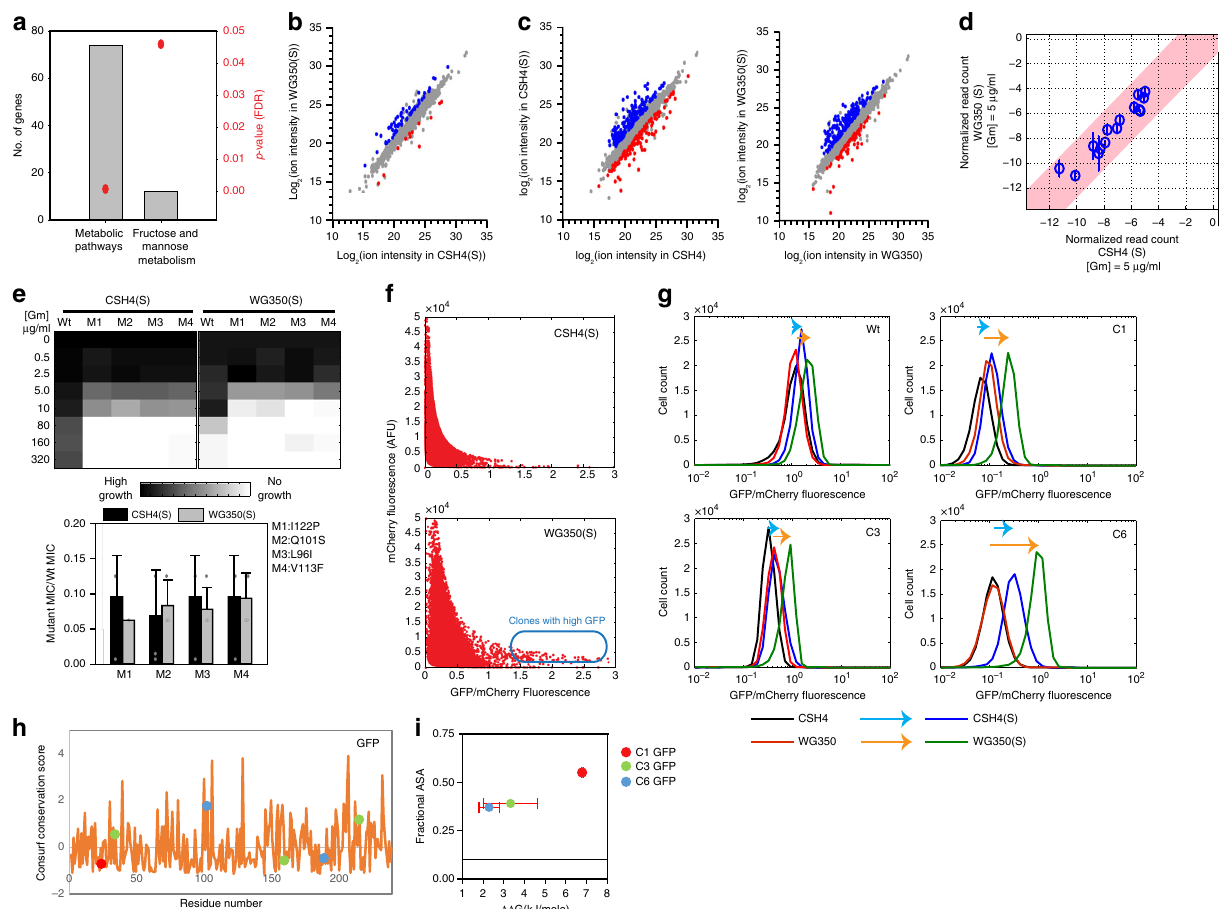
Fig. 3 Osmotic stress-induced changes in metabolism changes the spectrum of mutants buffered. a Gene Ontology (GO) classes upregulated in WG350 (S) transcriptome with respect to CSH4(S) shown as fold enrichment on the left-axis and Benjamini-Hochberg FDR corrected p -values obtained using DAVID on the right axis from two biological replicates. b Comparison of metabolites in WG350 and CSH4 during growth in media containing 350 mM NaCl using untargeted metabolomics. Colored circles represent signi fi cantly different metabolites obtained using paired 2-sided Student ’ s t -test. c Comparison of metabolites within strain in presence and absence of NaCl. Colored circles represent signi fi cantly different metabolites obtained using paired 2-sided Student ’ s t -test. d Mean of normalized read counts of Gm-R GG-mutant library at comparative selection pressure of Gentamicin (Gm) and 350 mM NaCl in growth media from two biological replicates. Pink shaded area marks 99% con fi dence interval. e Heatmap representing activity of small- molecule-dependent Gm-R mutants in CSH4(S) and WG350(S) at different concentrations of Gentamicin (Gm) (top panel). Bottom panel shows mutant MIC normalized with respect to Wt Gm-R in the respective strains. Mean with error bars representing standard deviation from four biological replicates is plotted (2-sided Student ’ s t -test p- value > 0.05). f The scatter plot for mCherry Vs GFP/mCherry fl uorescence of pool of GFP mutants with compromised fl uorescence (Pc) in WG350(S) and CSH4(S). Blue box indicates clones buffered in WG350(S). g Histogram of GFP/mCherry fl uorescence of Wt, C1, C3, and C6 GFP in WG350 and CSH4 in presence and absence of osmotic stress. Cyan arrow indicates increase in GFP fl uorescence upon addition of 350 mM NaCl to CSH4 strain, orange arrow indicates the same for WG350. h Conservation score (calculated using Consurf) for each residue. Dots indicate residues that are mutated in the clones studied. i Fractional ASA (calculated using VADAR) of the residues mutated in the clones is plotted against ΔΔ G of the residues obtained from 1GFL. Error bars represent standard deviation from three replicates (calculated using FoldX). For b and c : p -value < 0.05, fi ve biological replicates per sample. Also see Supplementary Fig. 2 (Source data are provided as source data fi le Fig. 3).